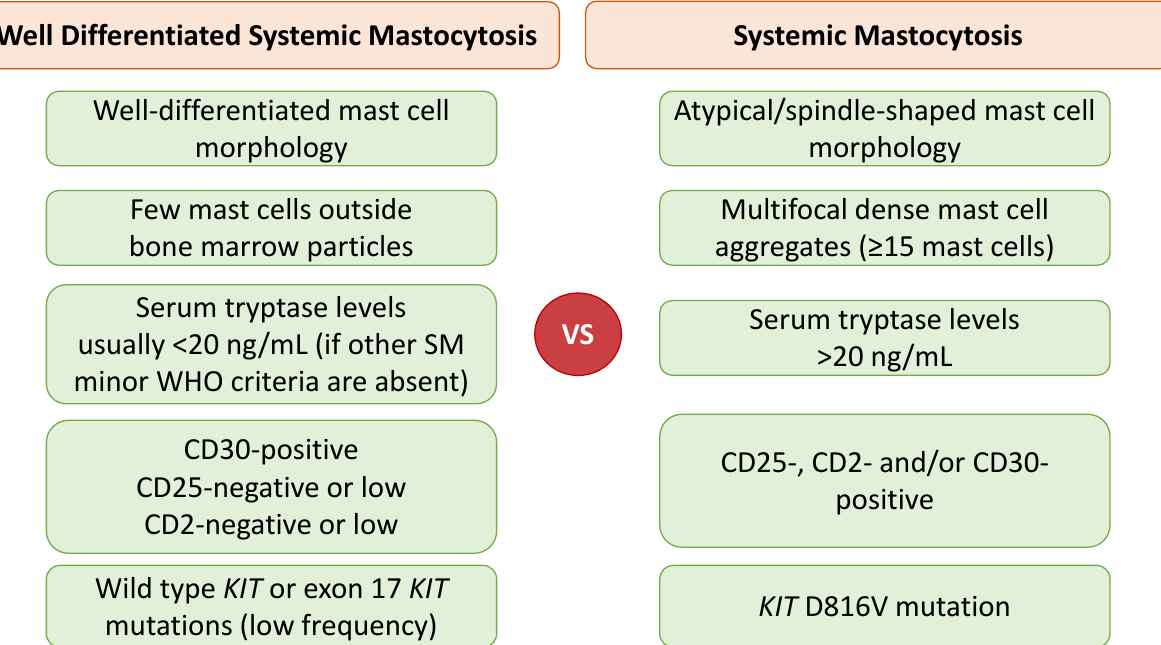
Figure 1. Comparison of current diagnostic criteria in systemic mastocytosis and clinical and patho- logic features detected in well-differentiated systemic